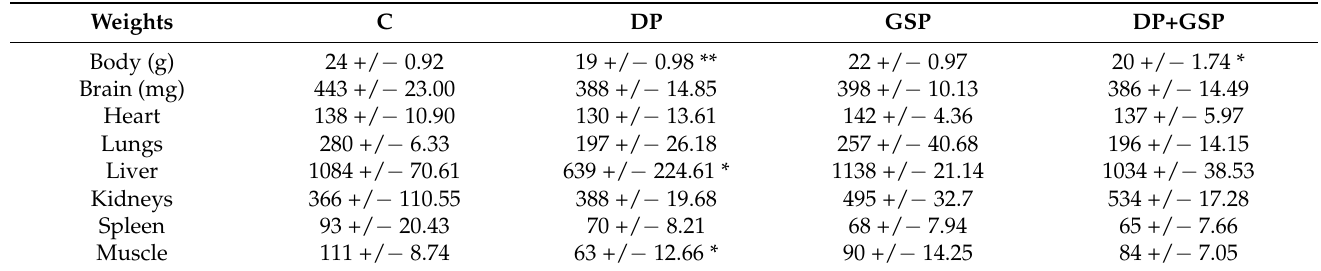
Figure 3. Effect of treatment on body weight. Body weights were measured at weekly intervals—baseline (week 11, when the mice were assigned to treatment groups), Tx (week 12, when treatment began), and every week thereafter until the endpoint. Data points indicate mean +/ − SEM. ( A ) Weight change within groups. The body weight of all groups progressively decreased throughout the course of the experiment. A statistically significant reduction from baseline in the weight of each group ( p < 0.05) was noticed by week 15 for group DP+GSP (*), and by week 17 for the three other groups (†). ( B ) Weight change between groups. The body weights of DP and DP+GSP were significantly less than C at Pre and Endpoint, * p < 0.05. Abbreviations: Tx, Beginning of treatment; Pre, 1 week prior to endpoint. Table 4. Body and organ weights. The weights of body and harvested tissues following necropsy and dissection are presented. Data are presented as mean +/ − SEM. Rows in bold indicate components in which weights significantly differed from the C group. * p < 0.05, ** p <